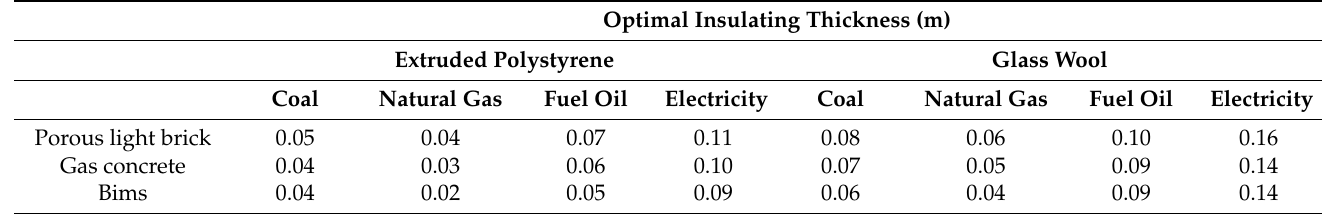
Table 6. Optimal insulating thickness depending on fuel and insulating materials for wall types.